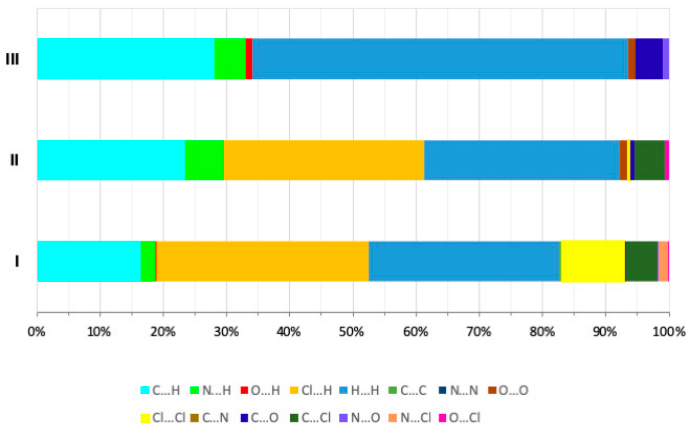
Figure 9. Fingerprint plots of compound I - III showing all the interactions taken from the Hirshfeld feld surface.